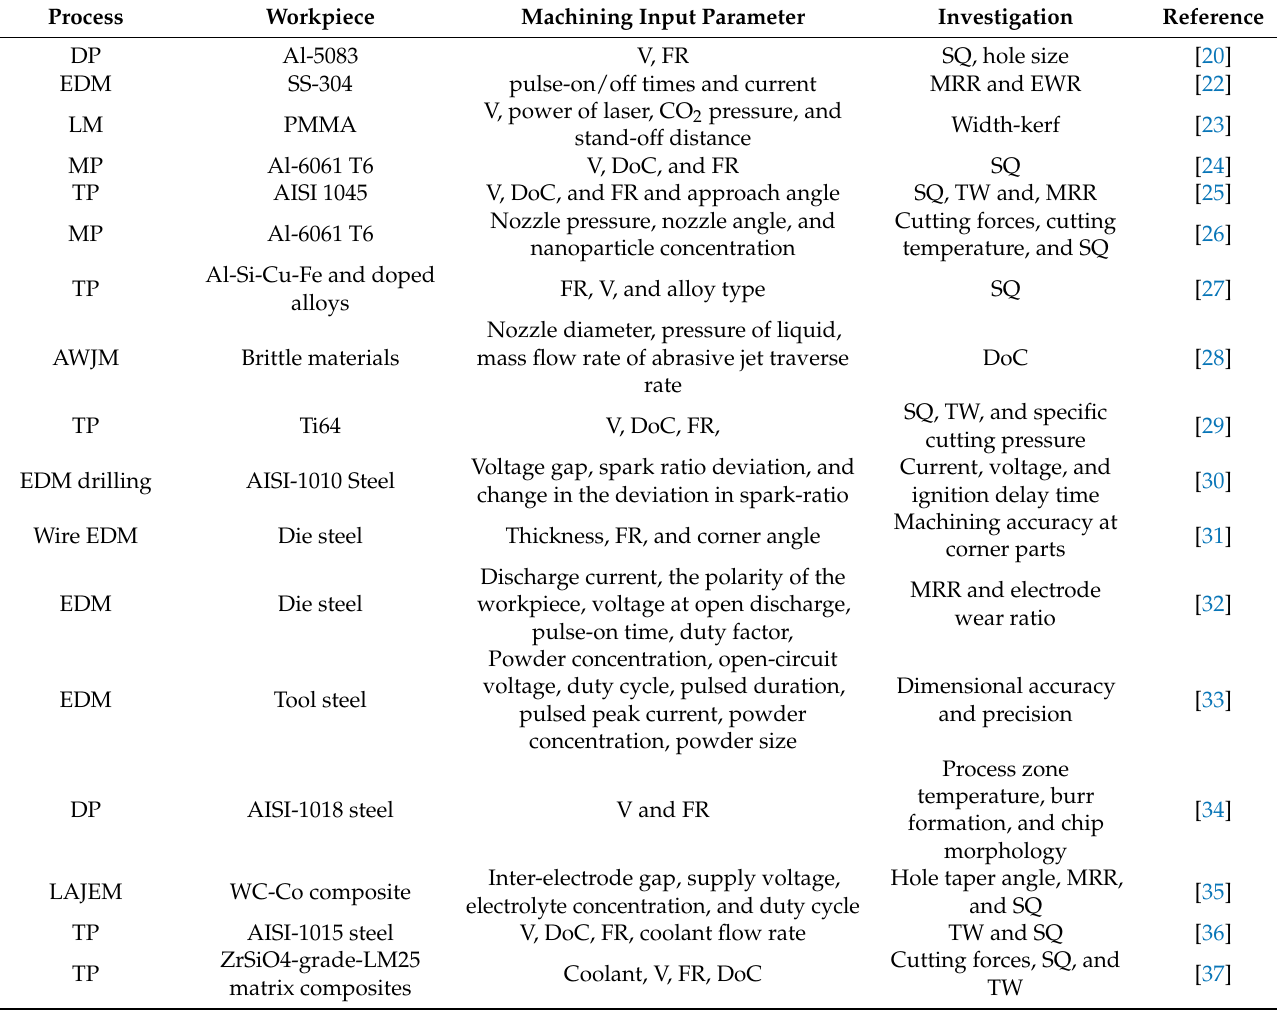
Table 1. The contribution of researchers using fuzzy logic tools in machining processes in recent years. Process Workpiece Machining Input Parameter